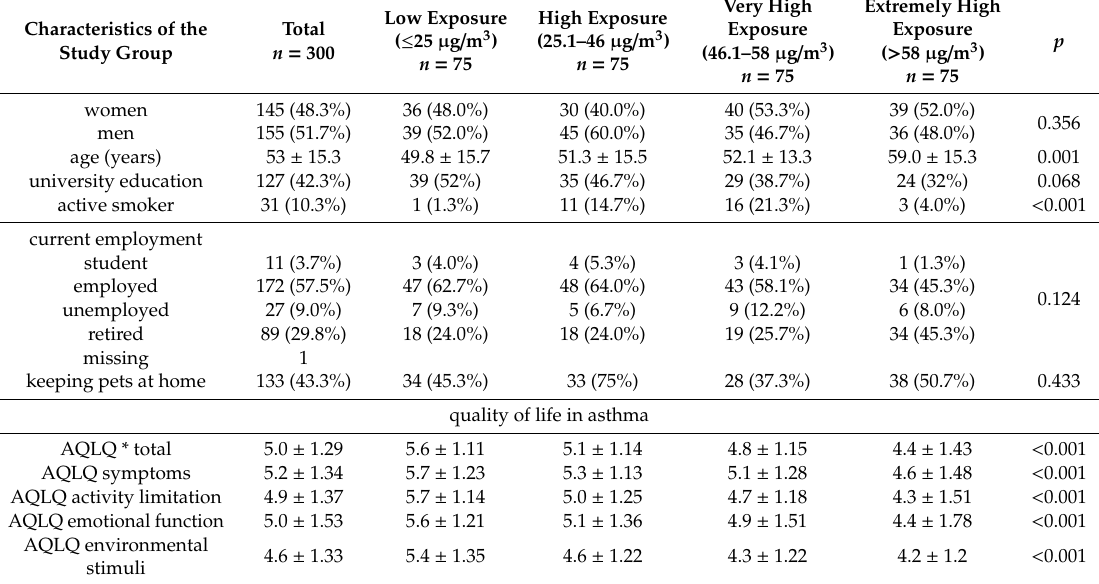
Table 1. Characteristics of the study group: all participants and participants divided in four groups based on quartiles of exposure to PM 2.5